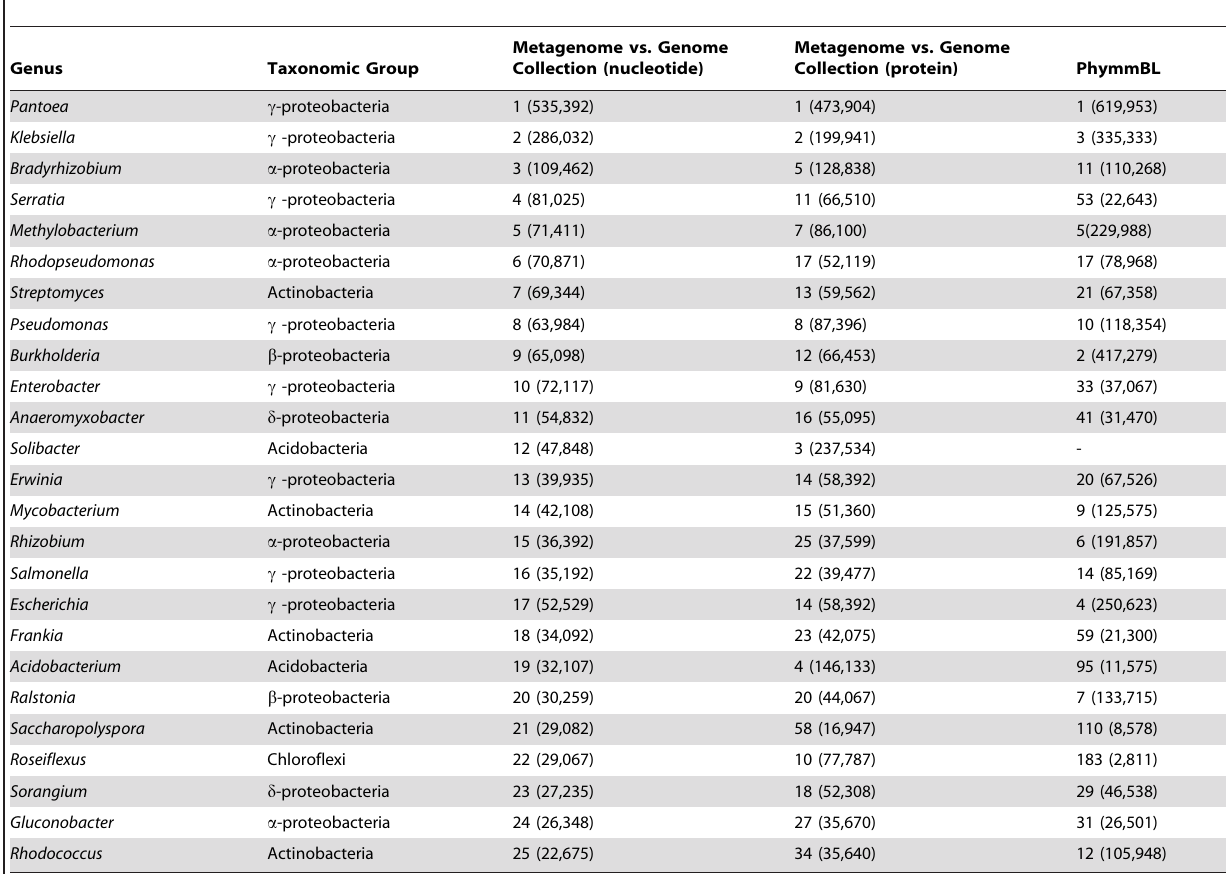
Table 1. Top 25 ranks and total nucleotide counts of the leaf-cutter ant fungus garden metagenome as phylogenetically binned using the complete microbial genome collection and PhymmBL.